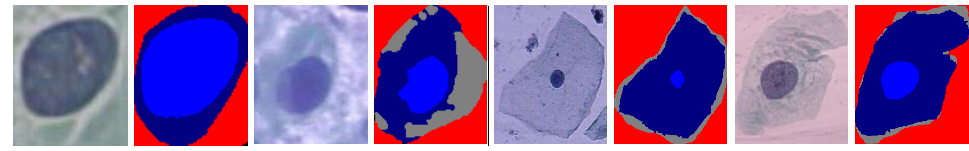
Figure 5. Sample cervical smear images and manual segmentation (ground truth) images [15–17]. Table 3. Classification of Pap smear single image cell types in the Herlev dataset [24].